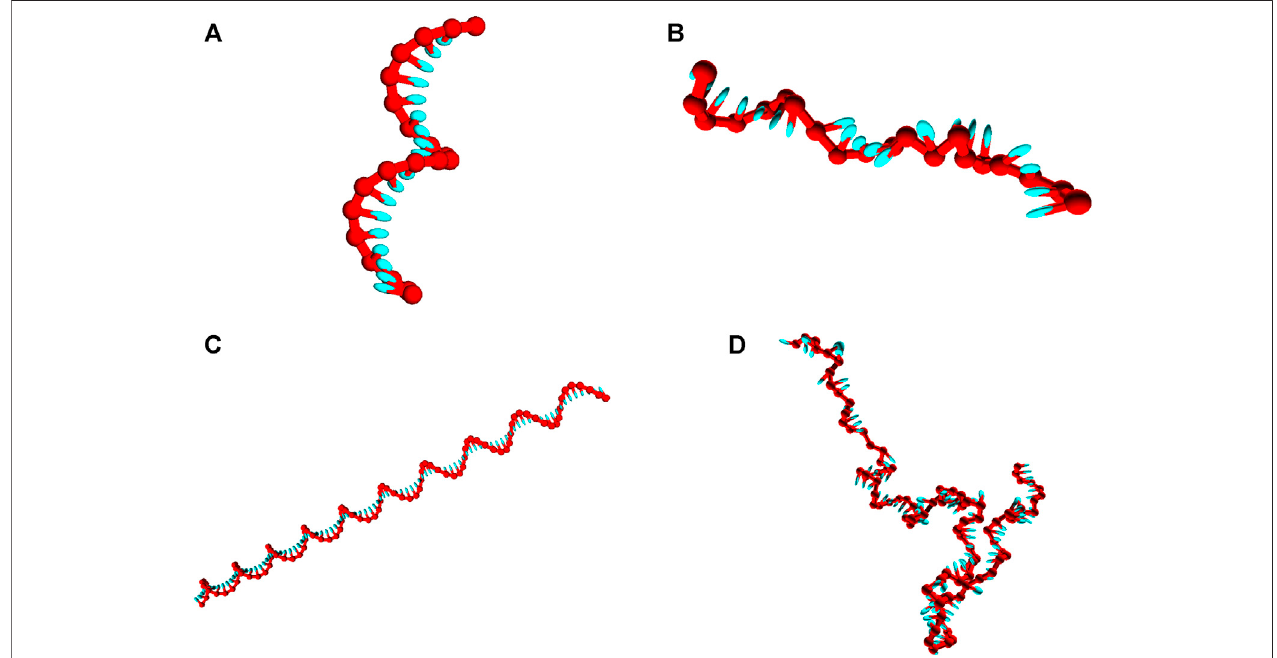
FIGURE 2 | Snapshots of poly (dT) molecules used in the equilibration time tests. Non-representative initial states of poly (dT) molecules (left) , and representative con fi gurations obtained post-equilibration (right) . (A) and (B) : poly (dT) with 20 nucleotides; (C) and (D) poly (dT) with 100 nucleotides.